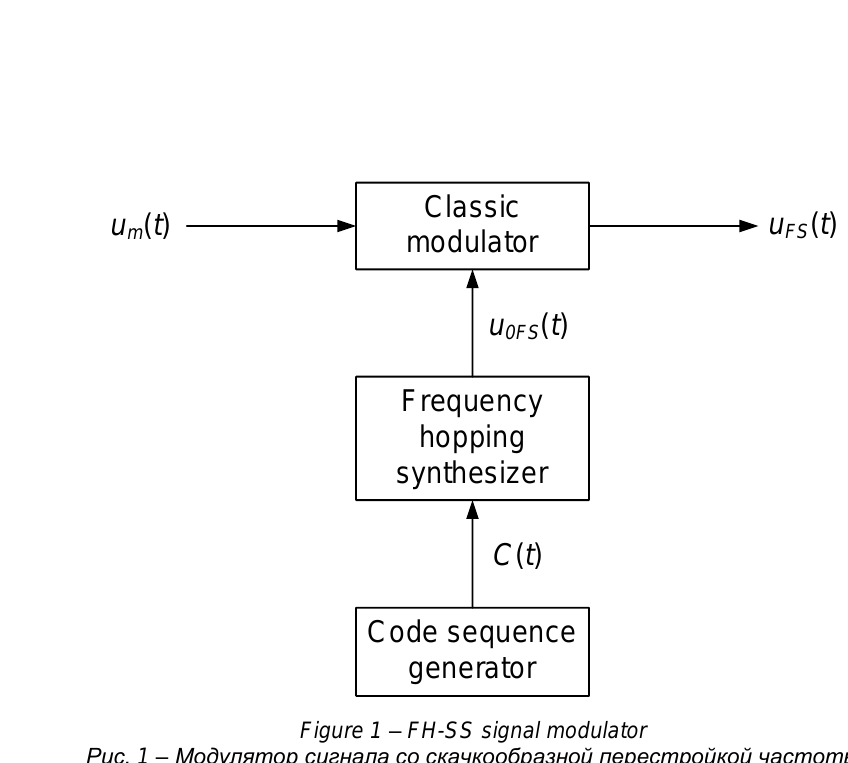
Figure 1 – FH-SS signal